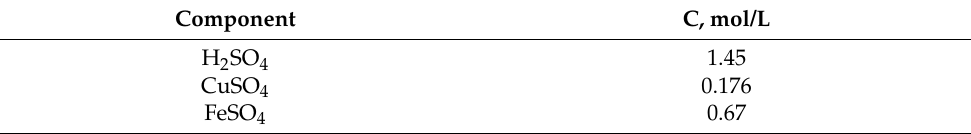
Table 2. The composition of waste